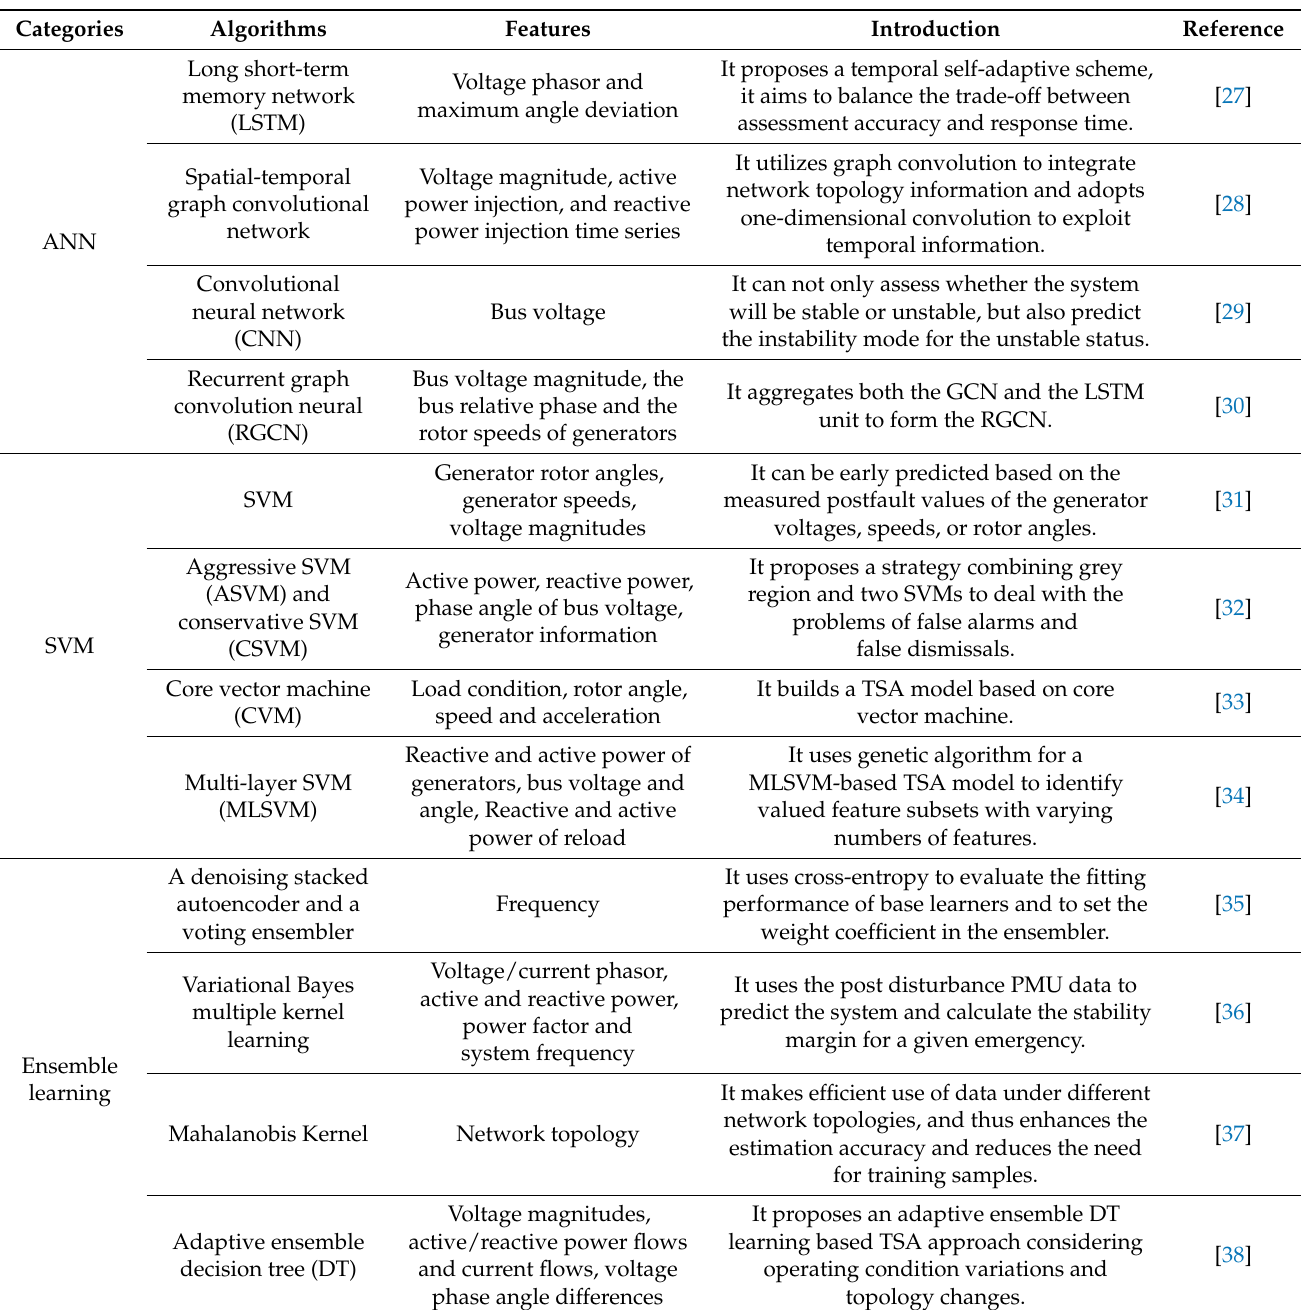
Table 2. Comparison of different TSA model construction